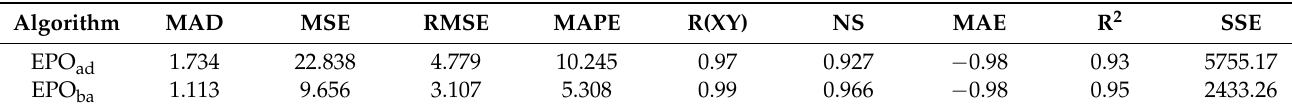
Figure 5. Convergence curve of HR extraction using EPO algorithms. Table 3. Validation results of EPO ba and EPO ad in simulating the